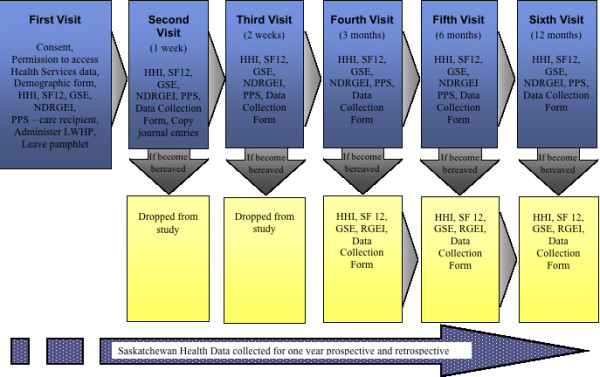
Data Collection.